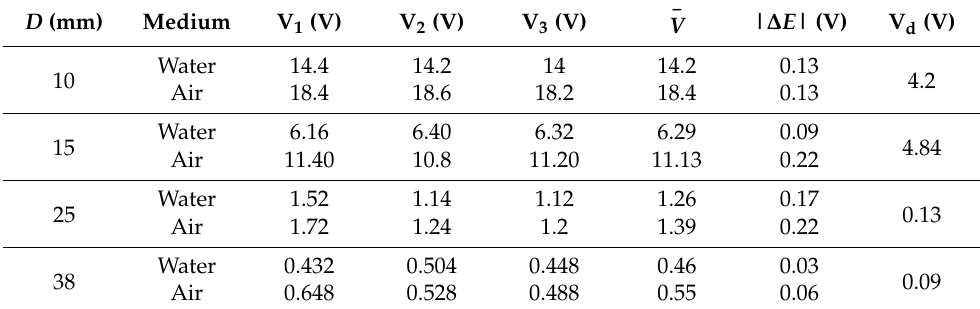
Table 3. Evaluations with different